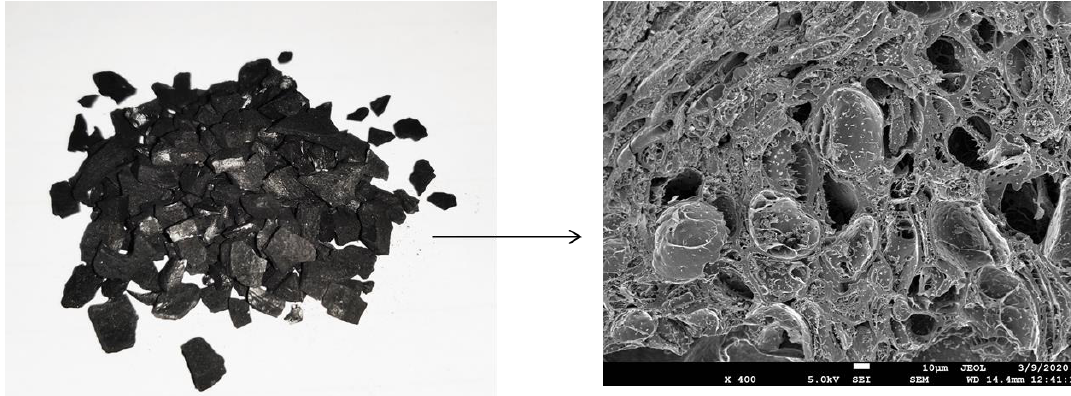
Figure 5. Macropores in activated carbon.